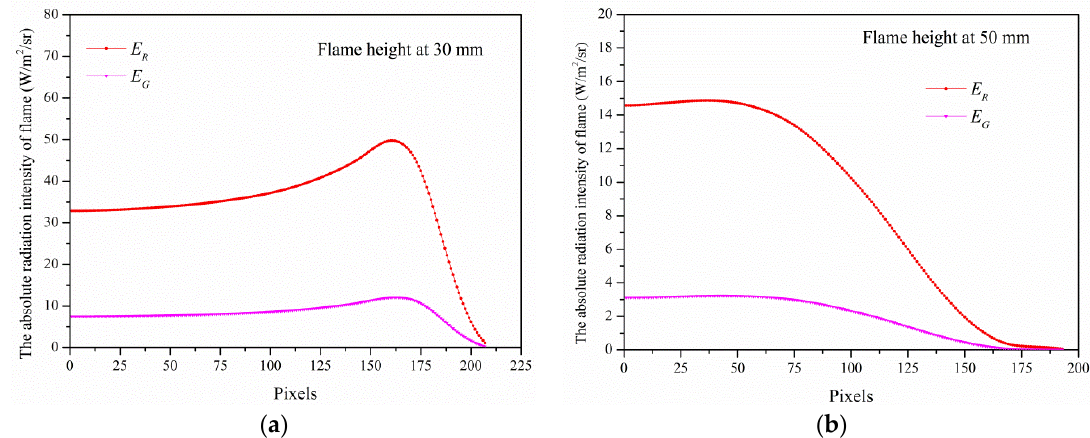
Figure 2. Measurement simulation of the absolute radiation intensity of the flame ( a ) at 30 mm high; and ( b ) at 50 mm high.